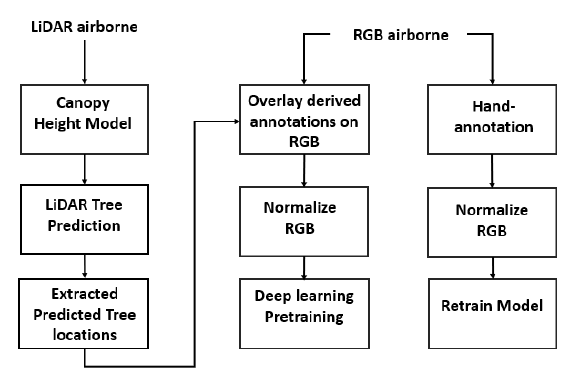
Figure 8. Prebuilt model training workflow. Redrawn from Weinstein et al. (2020).